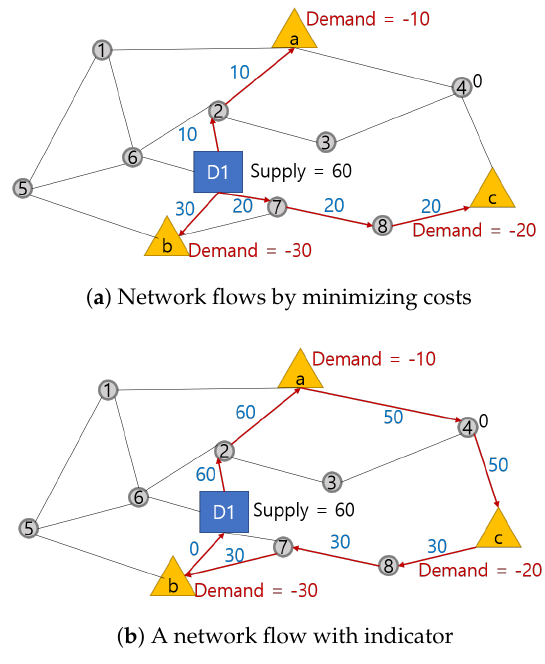
Figure 3. Network flows minimizing costs, with and without an